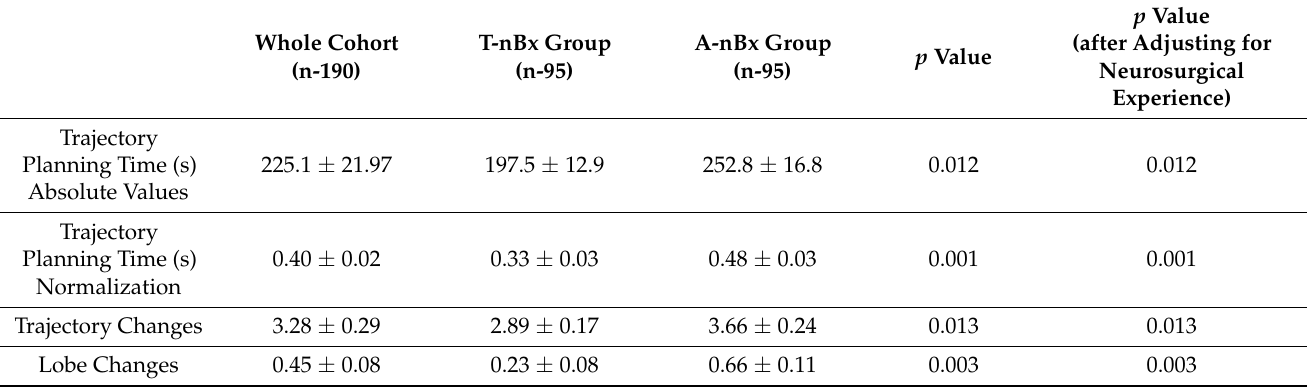
Table 1. Univariate Statistical Analysis of trajectory planning time (absolute and normalized), trajec- tory and lobe changes in the whole cohort and comparing both A-nBx and T-nBx